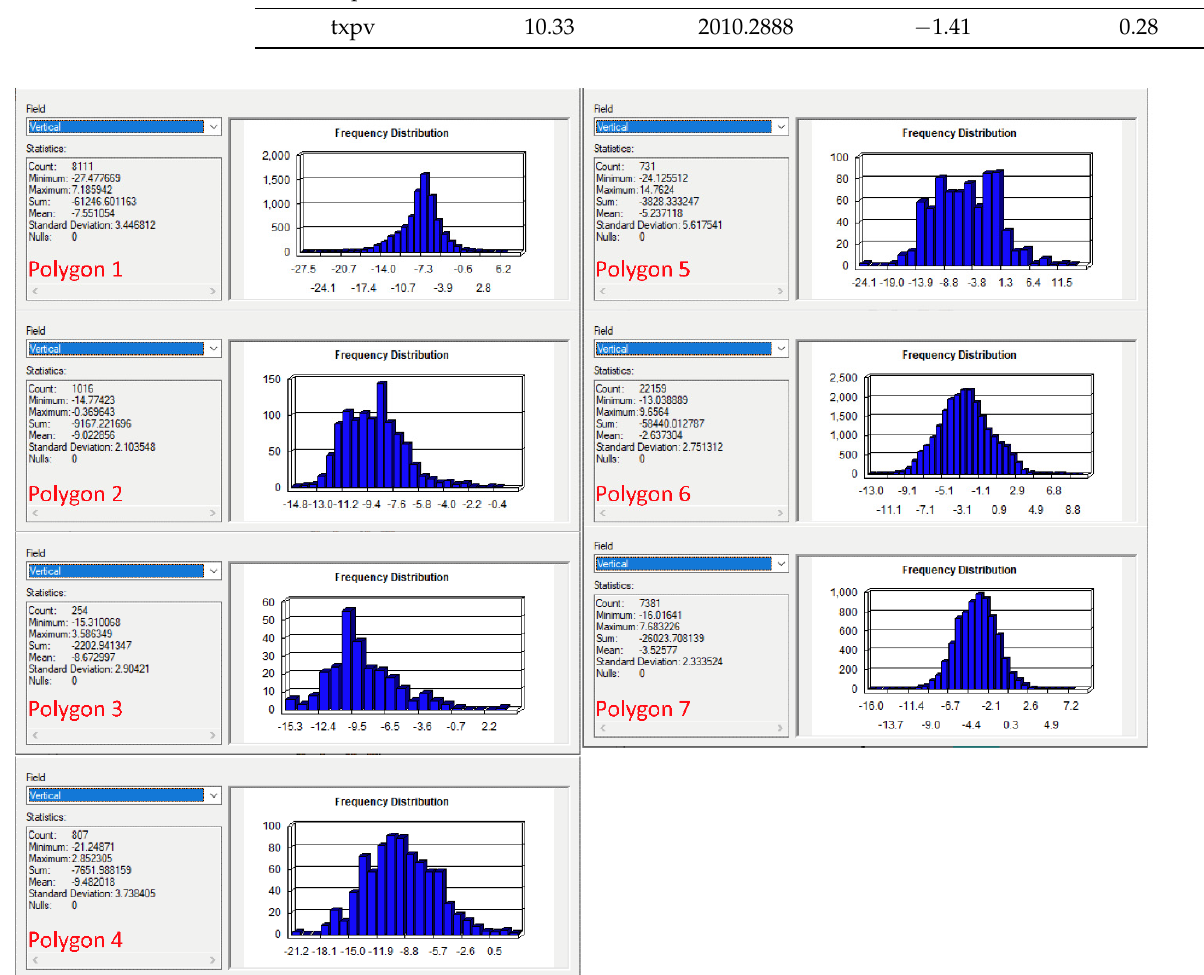
Figure A1. Histograms and statistics of InSAR-derived land subsidence rates over regions/polygons 1 − 7 shown in Figure 6a.